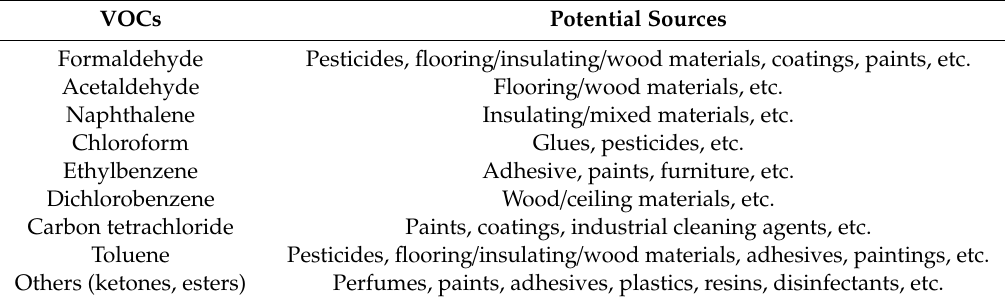
Table 1. Possible sources of indoor pollutants of volatile organic compounds (VOCs).